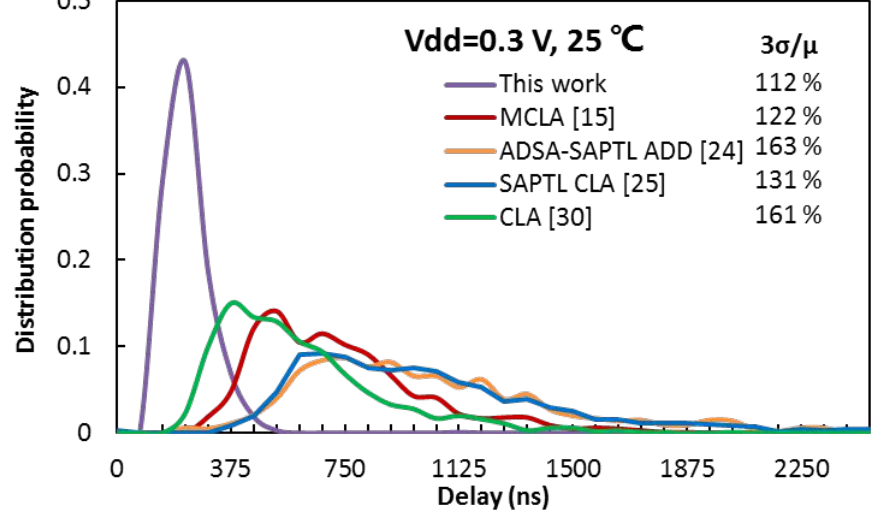
Figure 11. The statistical distributions of the delay at 0.3